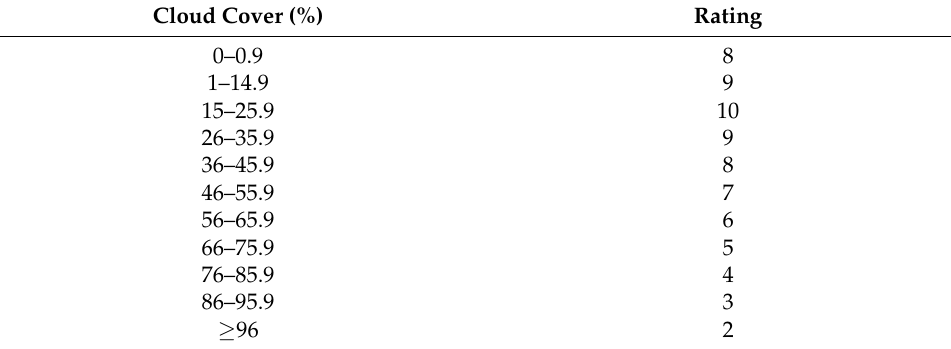
Table A4. Aesthetic facet rating values.